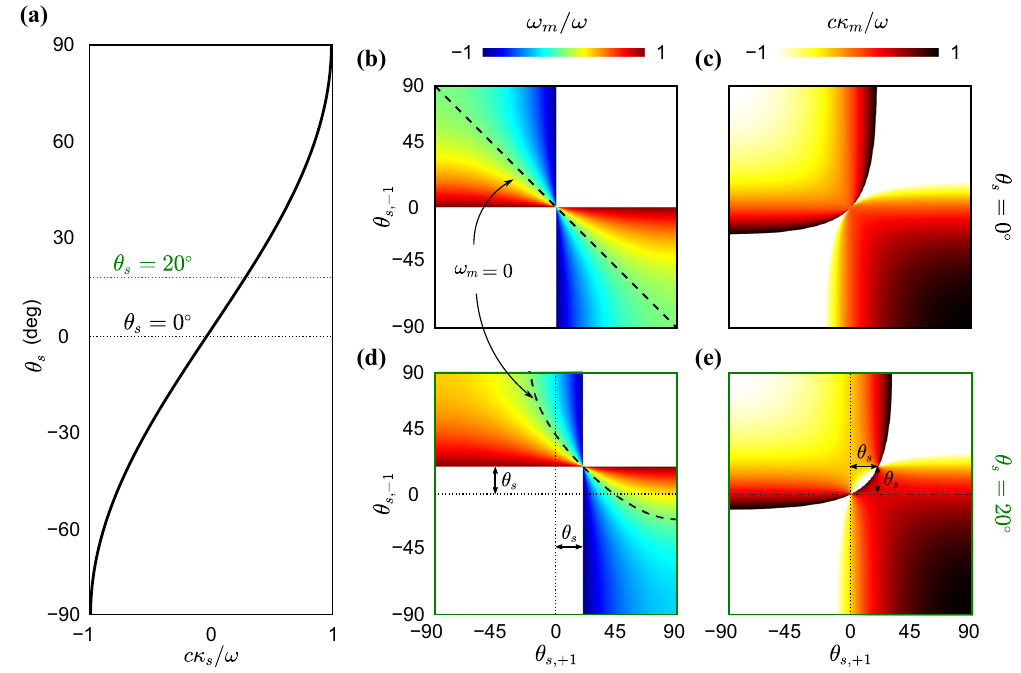
0 . The dashed line indicates ω m 0 . ( d – e ) The design 1 and θ s . 1 for a fixed θ s = = − + 20 . The dashed curve indicates 1 and θ s . 1 for a fixed θ s = − +